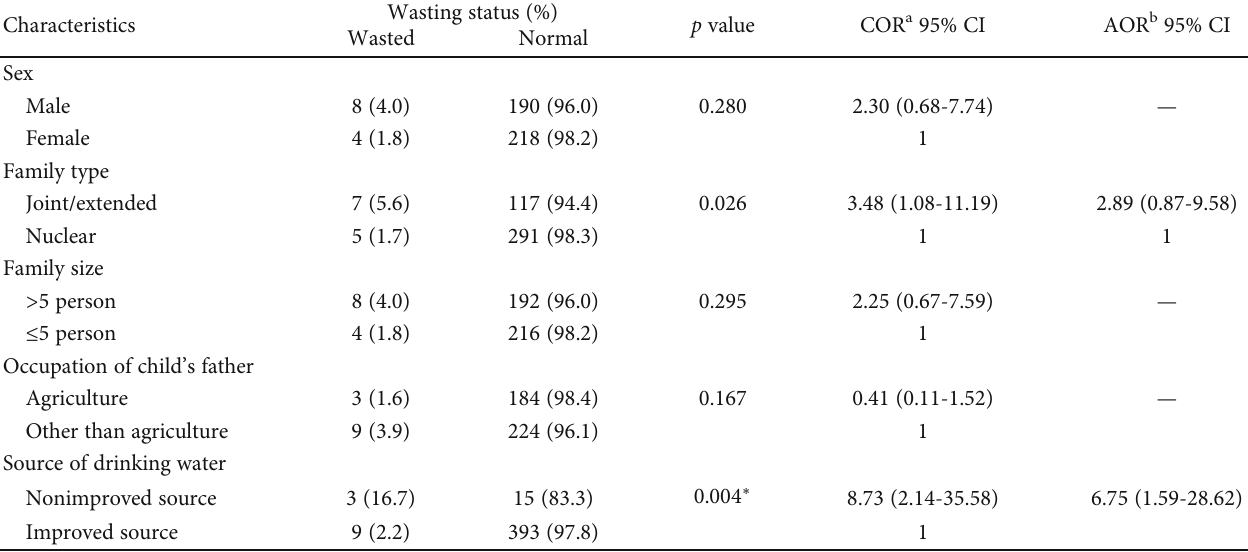
Table 7: Factors associated with wasting in using bivariate and multivariate analyses.